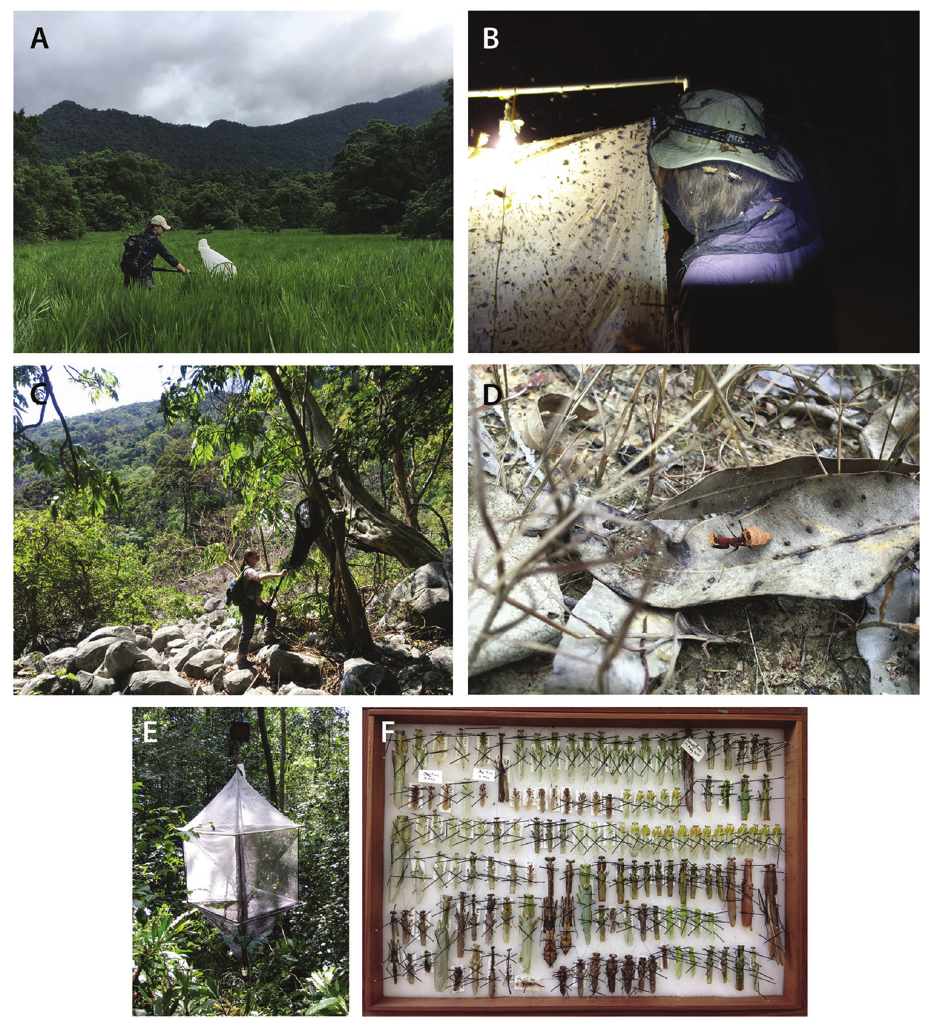
Figure 22. Mantis collecting techniques. A Sweeping vegetation with an insect net for the collection of grass-dwelling mantises B metal halide light trap set up to collect flight-capable mantises C scanning bark with the aid of an insect net for the collection of bark mantises D scanning the ground and leaf litter for ground-dwelling mantises E passive light trap set up to be suspended in tree canopies for the collection of canopy-dwelling mantises F field preparation of collected specimens secured with insect pins inside a Schmitt Box. It is recommended to thoroughly dry out preserved specimens in the sun, being mindful of ants and other scavengers, prior to travel back to home